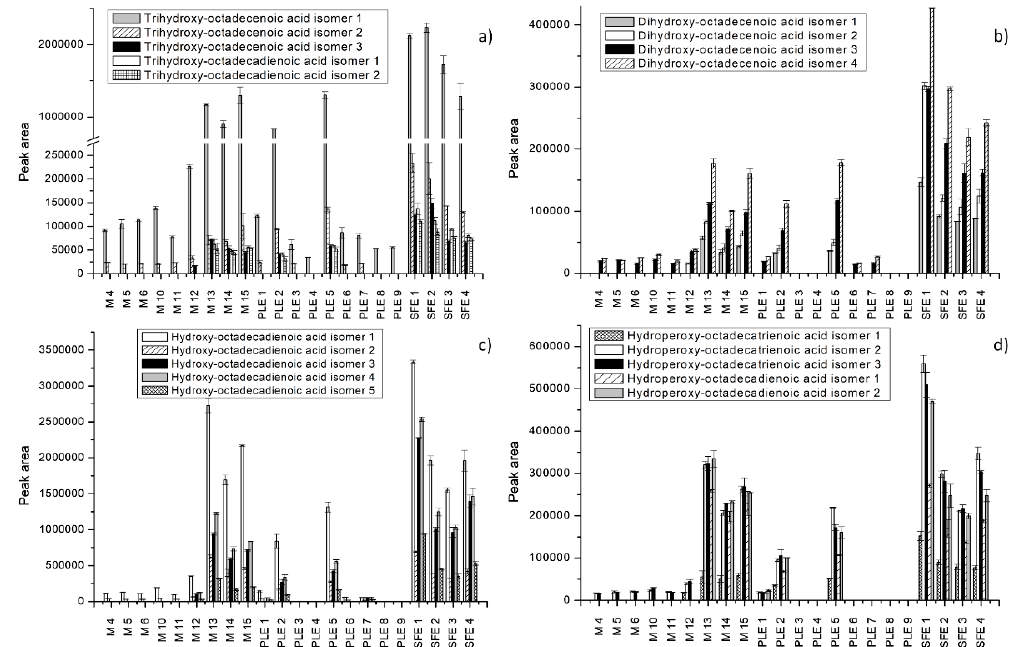
Figure 3. Extraction e ffi ciency of di ff erent extraction techniques expressed as peak areas of some fatty acids and derivatives. ( a , b ) Trihydroxy-octadecenoic acid isomers, trihydroxy-octadecadienoic acid isomers, and dixydroxy-octadecenoic acid isomers; ( c , d ) hydroxy-octadecadienoic acid isomers, hydroperoxy-octadecatrienoic acid isomers, and hydroxy-octadecadienoic acid isomers.